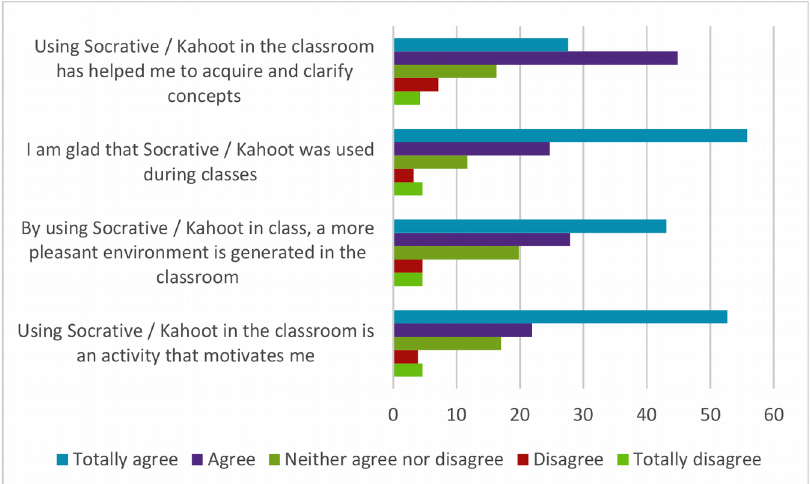
Figure 3. Degree of motivation, usefulness and student satisfaction